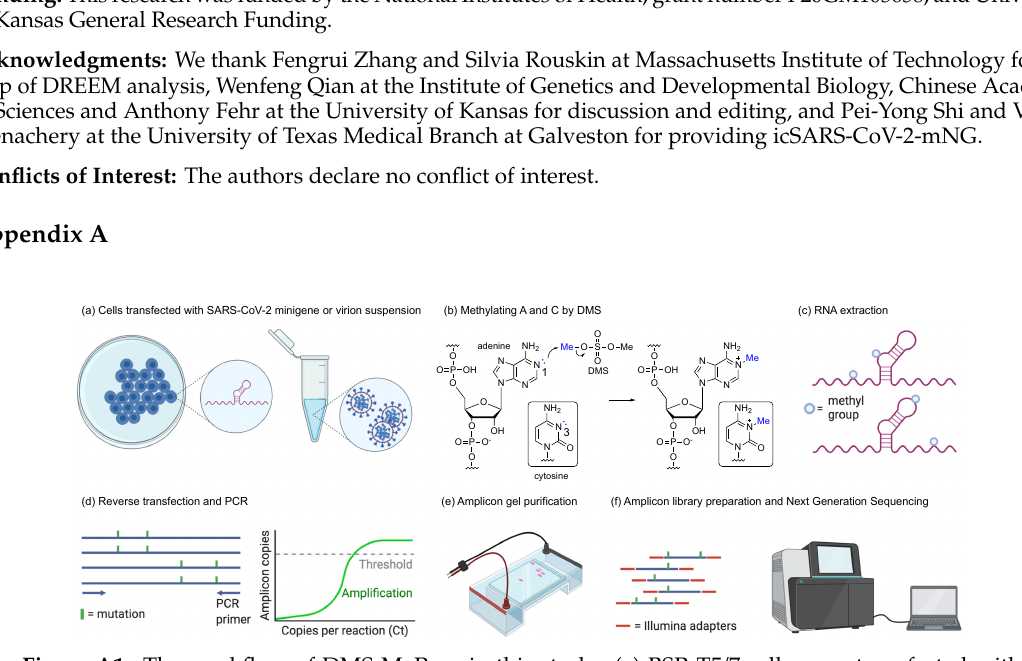
Figure S1: SARS-CoV-2 5 (cid:48) UTR structure derived from in vivo minigene DMS-MaPseq, Figure S2: Arc plots of all predicted possible base pairs for SARS-CoV-2 3 (cid:48) UTR, Figure S3: The predominant structures ( > 73%) of the S2M segment in the HVR determined by the DREEM analysis, Figure S4: DREEM analysis on the whole HVR does not yield a predominant conformer, Figure S5: The mutation rate in each 3 (cid:48) UTR nucleotide from 11,704 clinically isolated SARS-CoV-2 specimens, Figure S6: The mutation rates, read depths, and reactivity distribution of the in vivo minigene, in-virion and in vitro DMS-MaPseq using the ShapeMapper2 pipeline, Table S1: The normalized DMS activities ( ∆ nDMS) and standard errors in the 3 (cid:48) UTR under di ff erent DMS settings, The SARS-CoV-2 minigene plasmid (pUC57-COVID-MG) sequence, The terminal command lines for deltaSHAPE and DREEM analysis in BSL / SL1 RNA segments with Parallel [43], Names of the SARS-CoV-2 sequences that are truncated in S3-B (collected and deposited in GISAID database on or before 6 November 2020), modified python programs Superfold.py (for SuperFold) and EM_ExpandFold.py (for DREEM).